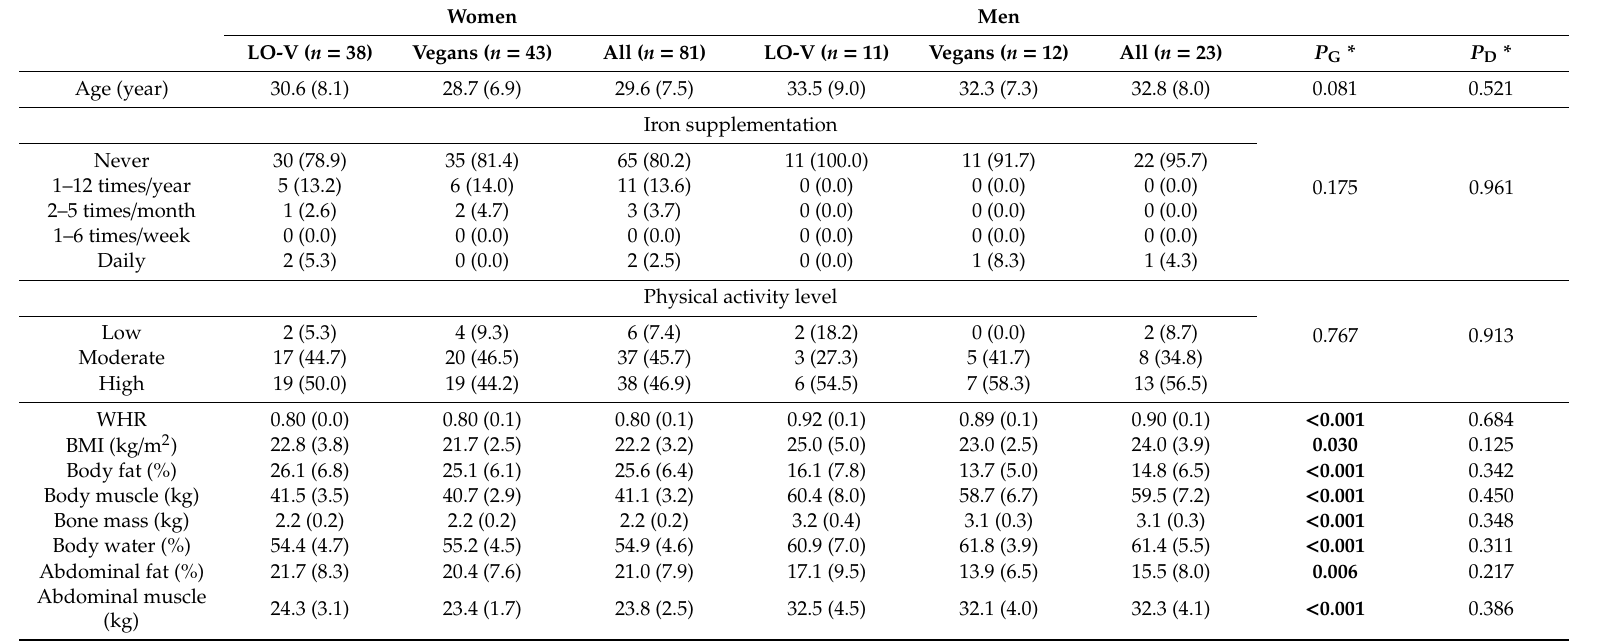
Table 1. The characteristics of the